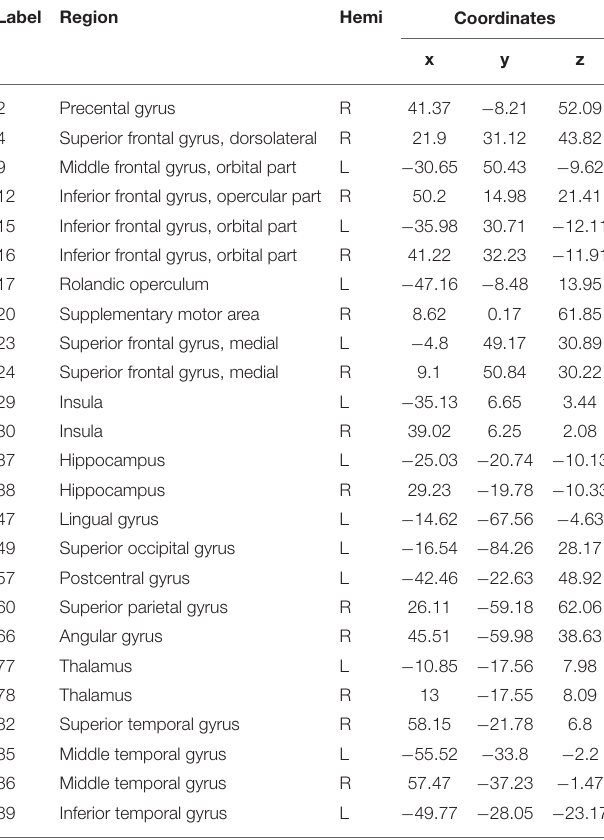
TABLE 4 | Regions displaying high disagreement between ASD and control group for community cluster assignment. Label Region